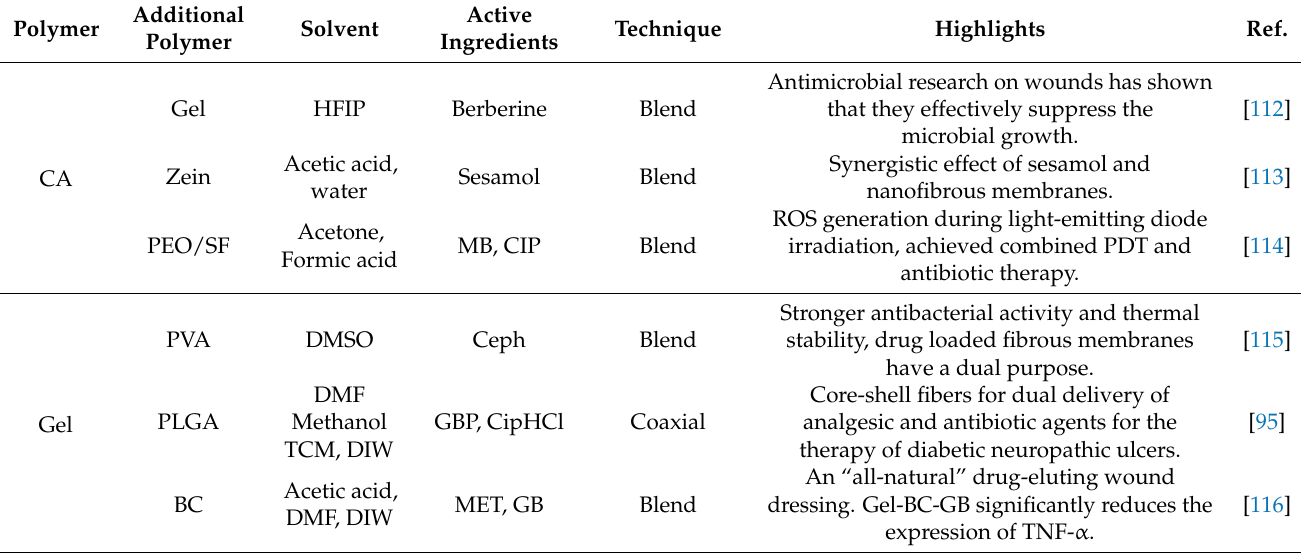
Table 1. Summary of applications on the application of conventional polymeric materials generated by electrospinning to improve diabetic wound